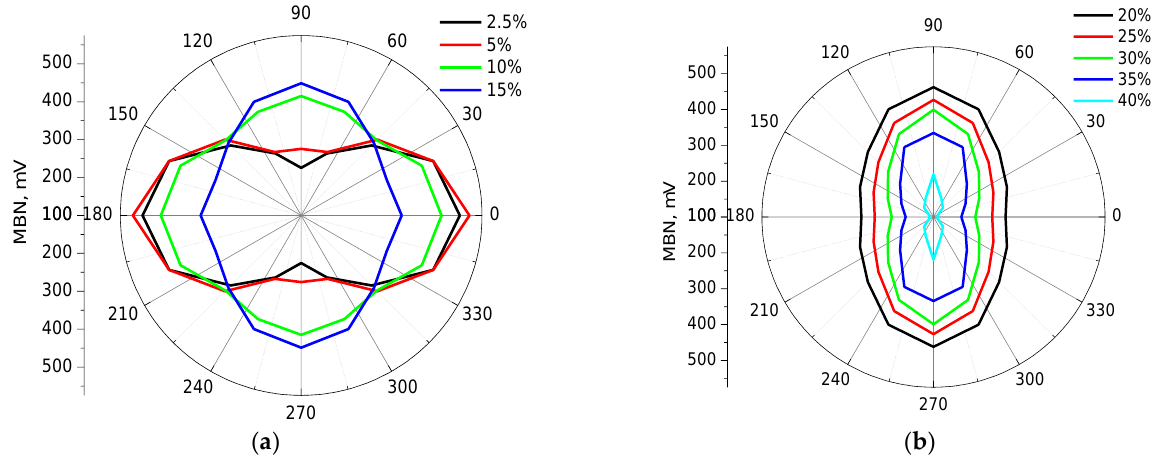
Figure 8. Angular dependence of magnetic Barkhausen noise (MBN) as a function of ε . ( a ) ε = 2.5 ÷ 15%, ( b ) ε = 20 ÷ 40%; 0° corresponds to the rolling direction (RD).